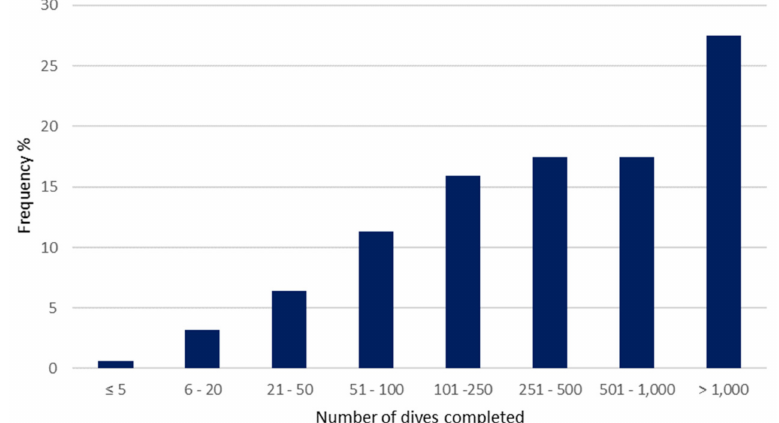
Figure 2. Number of dives completed.